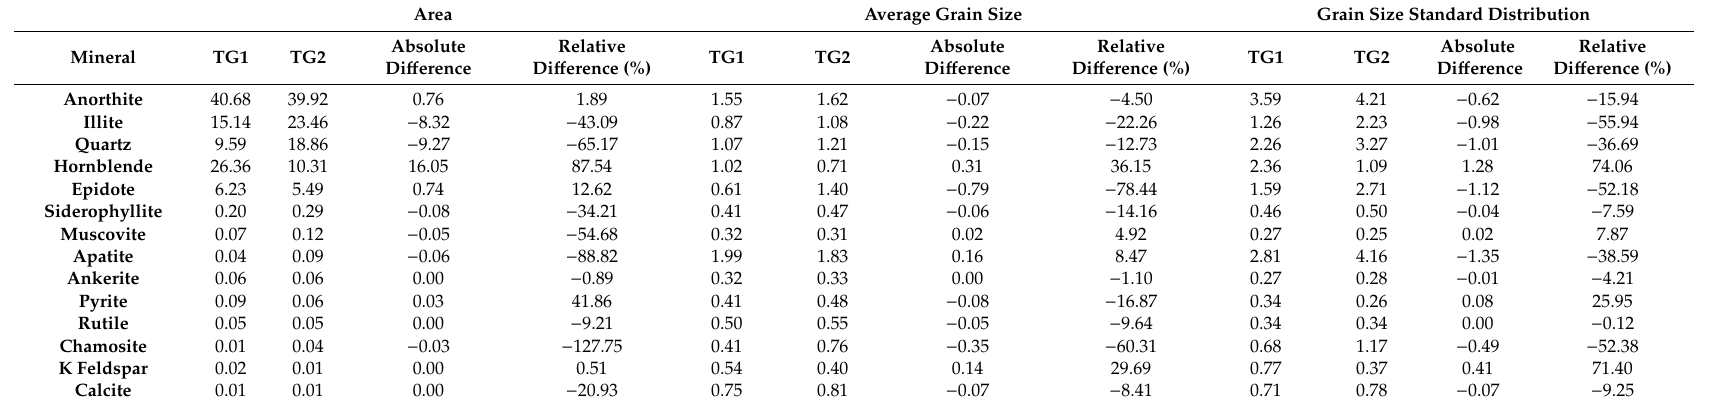
Table 2. Modal mineralogy and grain size distribution data for textural groups 1 (TG1) and 2 (TG2) and comparative modal mineralogy and grain size distribution data for TG1 and